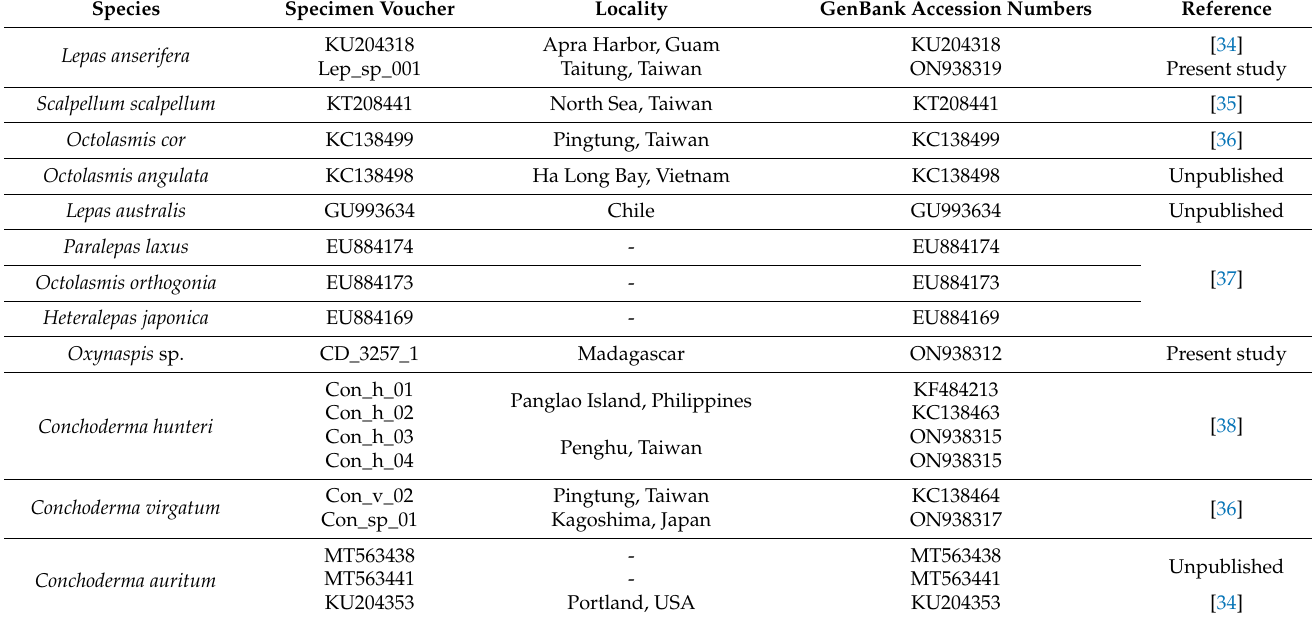
Table 1. Specimen information and GenBank accession numbers for DNA